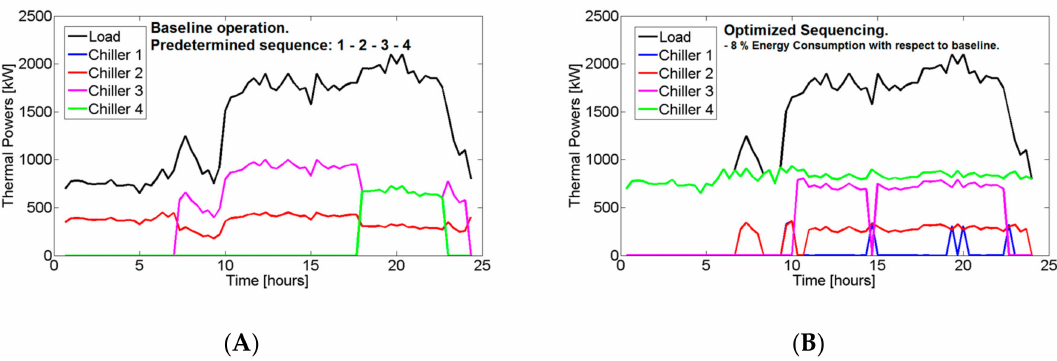
Figure 9. Optimized sequencing control ECM for district chiller plant. ( A ) Baseline system operation; ( B ) Optimized sequencing control.